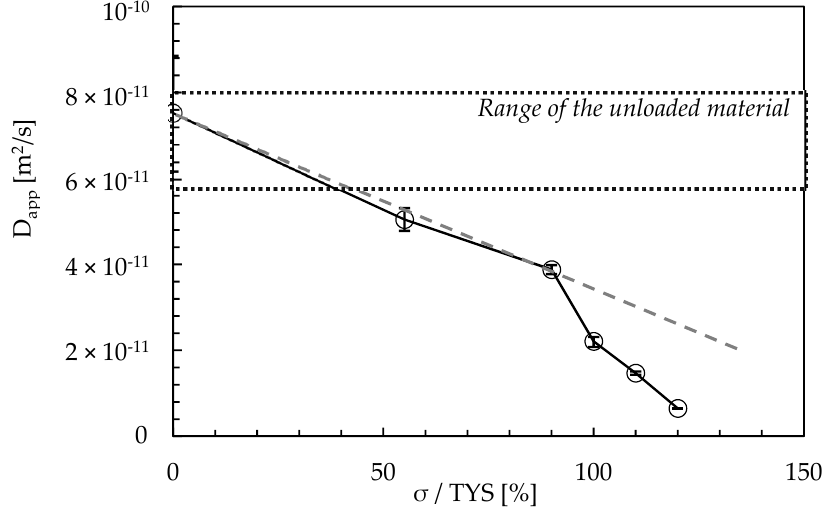
Figure 4. Relation between D app (apparent diffusivity) and applied stress.